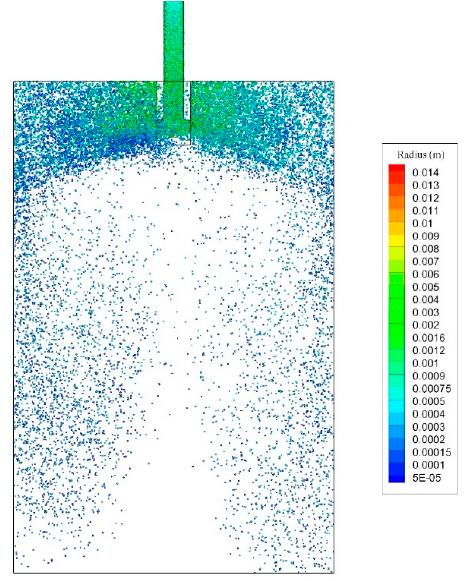
Figure 5. Fluid velocity and streamlines in the mold.